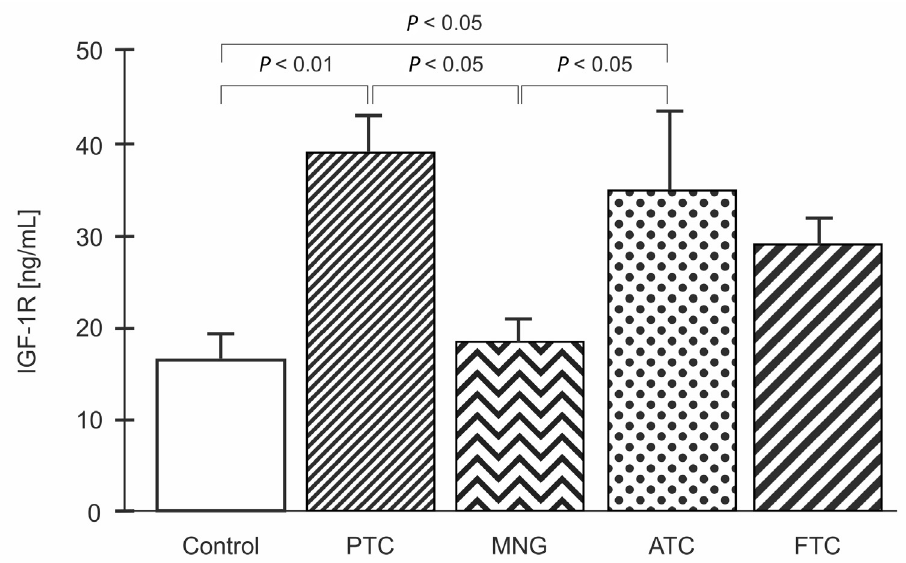
Fig. 2. Mean serum concentration of IGF-1R (ng/mL) in patients diagnosed with papillary thy- roid cancer, follicular thyroid cancer, anaplastic thyroid cancer, multinodular goiter and healthy volunteers. Bars represent mean ±